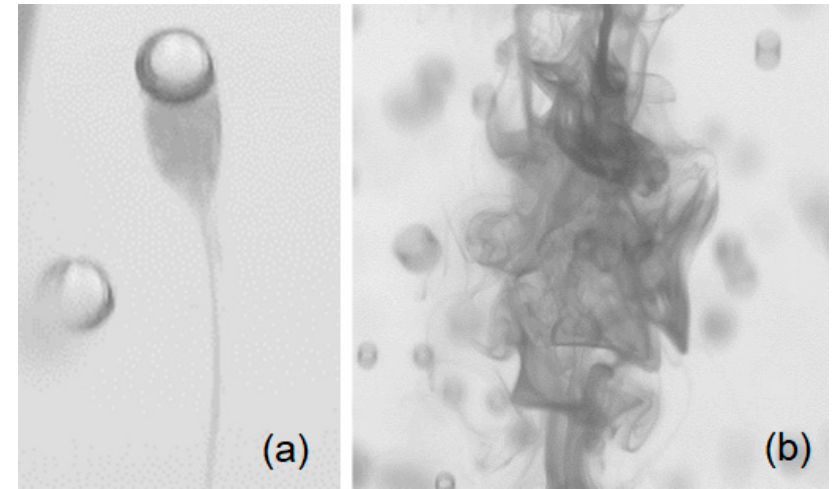
Figure 1. Diffusion of a passive scalar (dye shown as the darker regions) under bubble induced mixing via ( a ) wake transport and ( b ) bubble-induced turbulence.